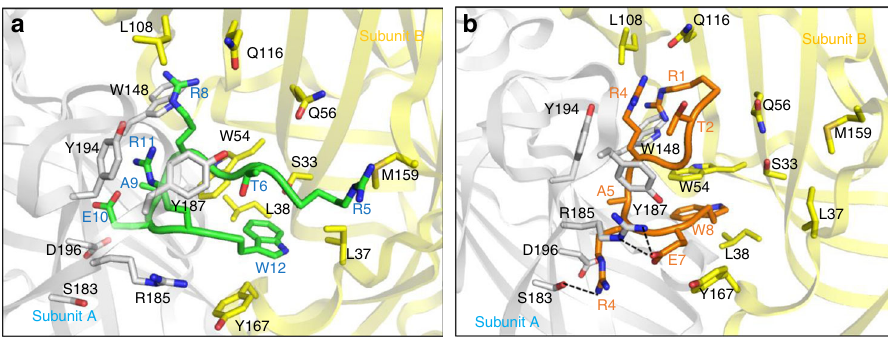
Fig. 6 Binding mode of peptides with α 7 nAChR. D CDX-S8 (green, a ) and D8 (brown, b ) with α 7 nAChR is shown. Subunit A of receptor is shown in white and subunit B is in yellow. Residues involved in binding are represented by sticks, and hydrogen bonds are denoted by black dashed